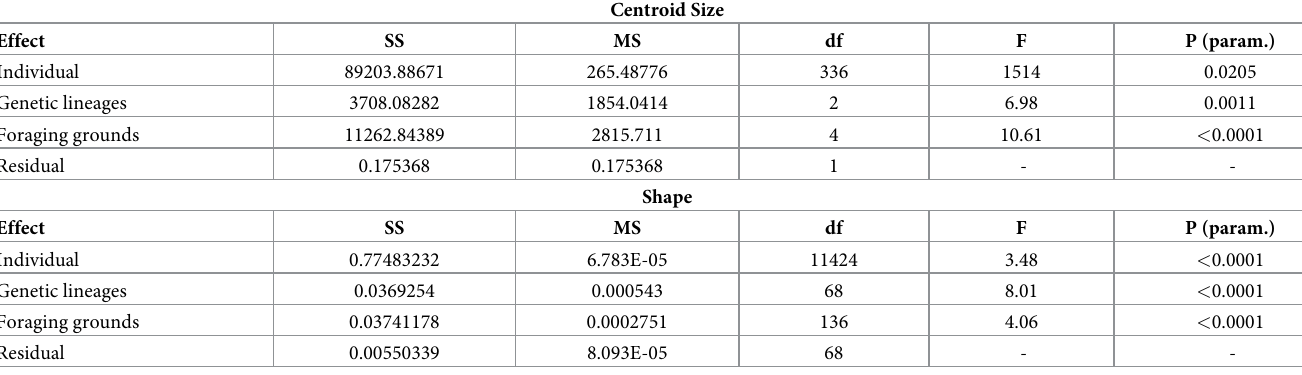
Table 1. Procrustes ANOVA performed to assess significance between genetic lineages and foraging grounds on both centroid size and shape of Chelonia mydas . Sums of squares (SS) and mean squares (MS) are in units of Procrustes distances (dimensionless).